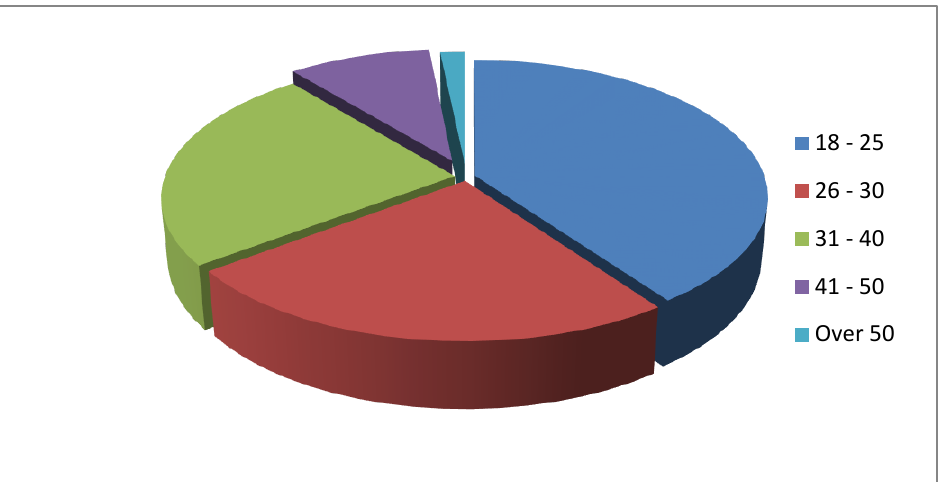
Figure 4 indicates that the age group consisted of 39.9% of learners aged between 18 and 25, 24.3% of learners were aged between 26 and 30, and 24.3% of learners were aged between 31 and 40. Table 4 also shows that 9.3% of learners were aged between 41 and 50 and 1.6% of learners were over 50 years of age.